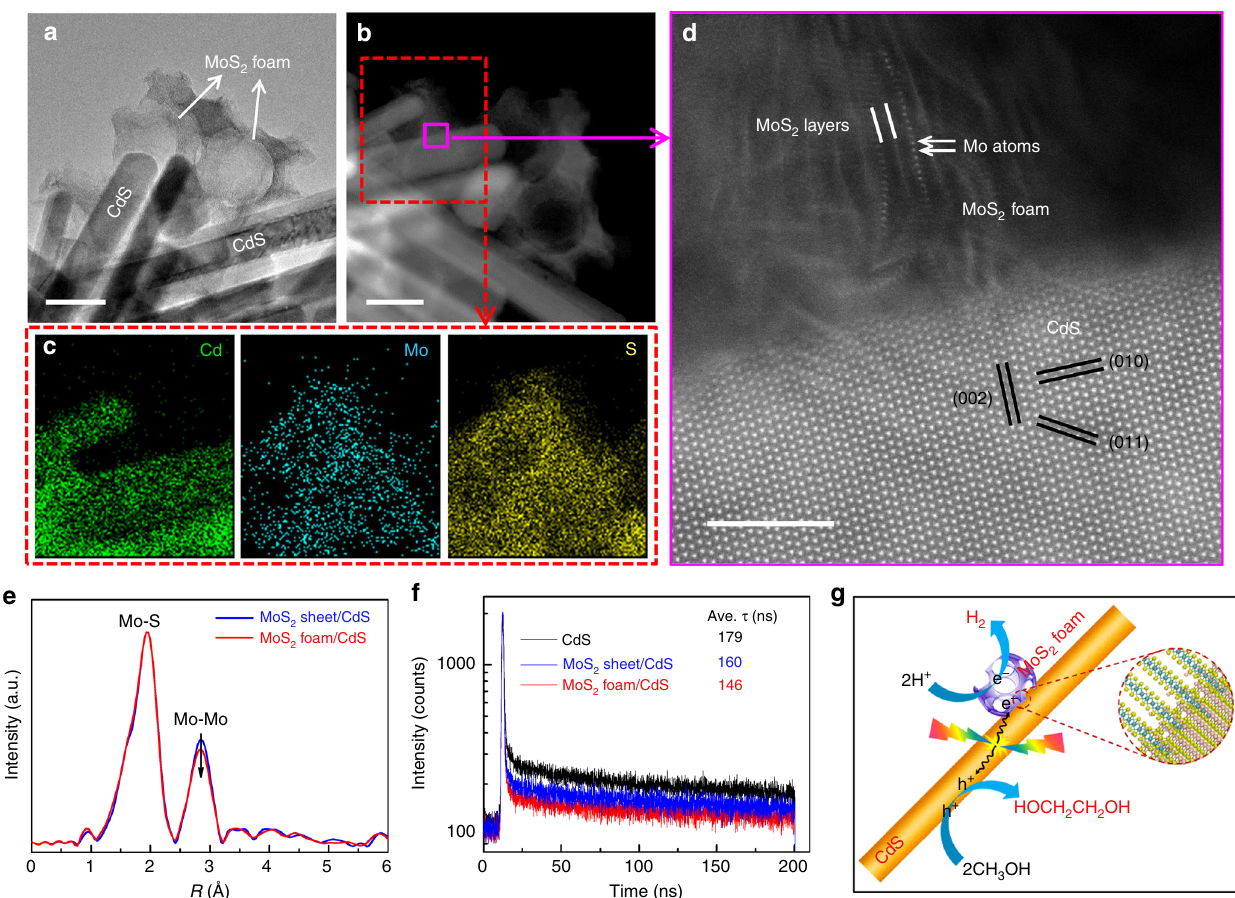
Fig. 1 Structural and physicochemical properties of the MoS 2 foam/CdS catalyst. a TEM image of MoS 2 foam/CdS. b HAADF-STEM image of MoS 2 foam/ CdS. c Corresponding EDX maps with a red rectangle in HAADF-STEM image of b showing the element distribution of Cd, Mo, and S. d High-resolution HAADF-STEM image of MoS 2 foam/CdS. e The k 2 -weighted EXAFS spectrum of MoS 2 foam/CdS versus that of MoS 2 sheet/CdS. f Time-resolved photoluminescence (TRPL) spectra of CdS, MoS 2 sheet/CdS, and MoS 2 foam/CdS. g Schematic illustration of MoS 2 foam/CdS for photocatalytic synthesis of EG and H 2 from CH 3 OH. Blue and red lines in e and f represent MoS 2 sheet/CdS and MoS 2 foam/CdS, respectively. The black line in f represents CdS. Scale bar: a , b 50 nm; d 5